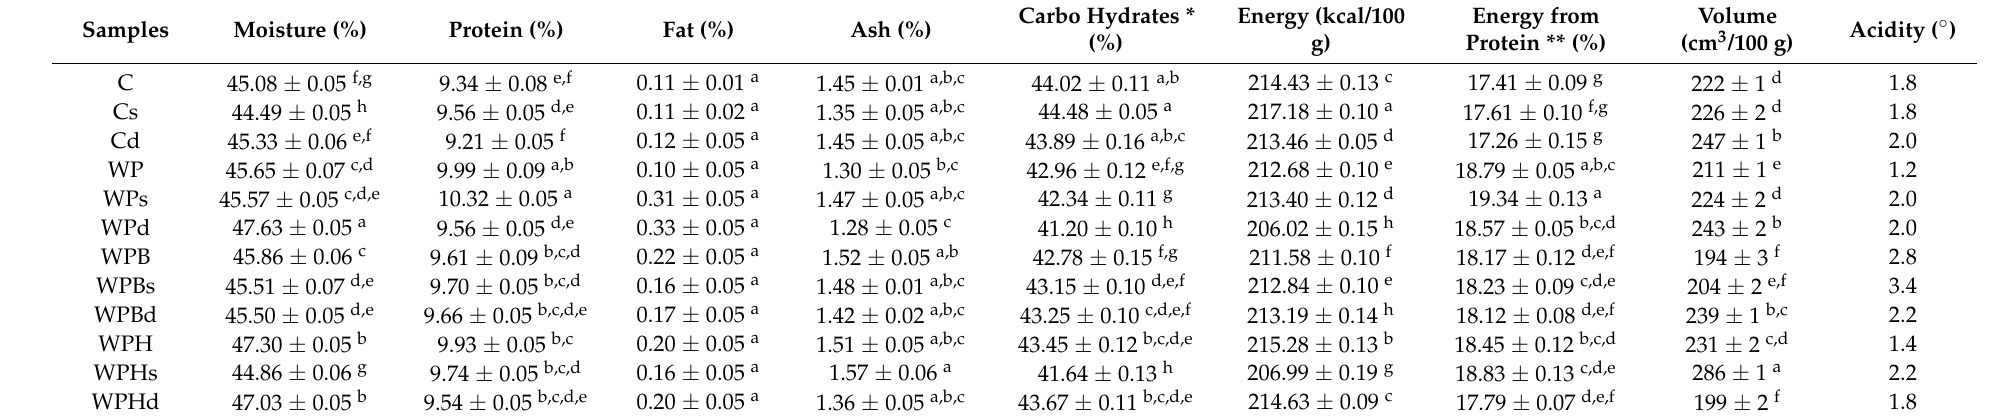
Table 3. Compositional analysis of breads (expressed in % of the fresh